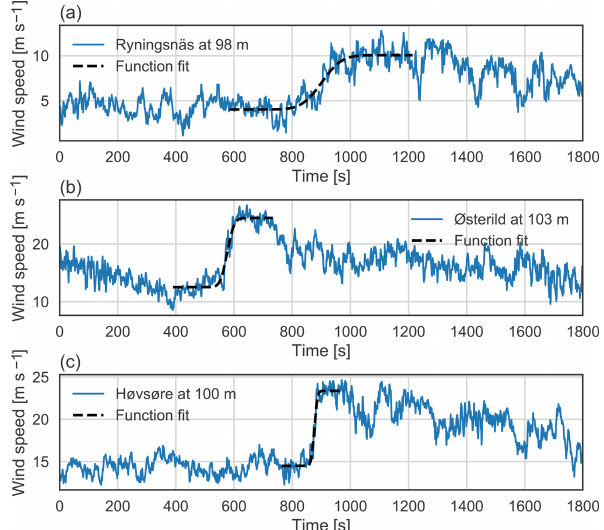
Figure 4. Three examples of the idealized ramp function fit to the wind speed measurements. Measurements from (a) Ryningsnäs, (b) Østerild, and (c) Høvsøre. The blue lines show the measure- ments and the dashed black lines show the idealized ramp function fit to a subset of the measurement.